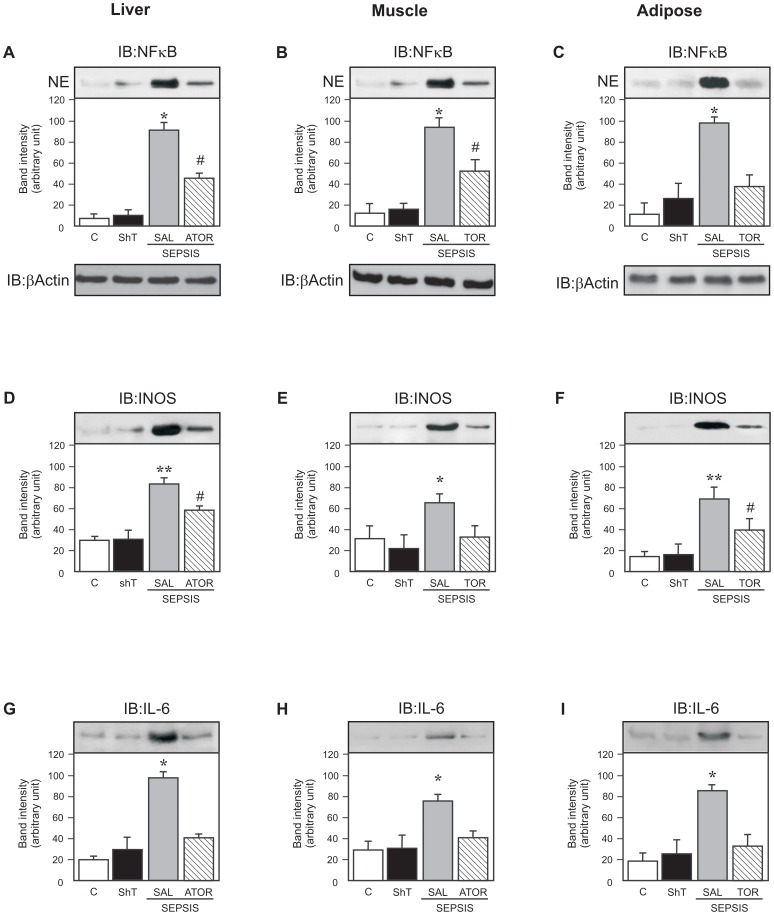
Representative blots show the NFkB activation in nuclear fractions of liver (A), muscle (B) and adipose tissue (C) of sham and septic rats.In this case blots were stripped and reprobed with actin (A–C, lower panels) to confirm equal loading of proteins. Tissue levels of iNOS (D–F) and IL-6 (G–I) expression in liver, muscle and adipose tissue of sham and septic rats. Data are presented as means ± S.E.M from 6–8 rats per group. *P<0.05 (Sepsis/Sal vs. all others groups); **P<0.001 (Sepsis/Sal vs. control); #P<0.05 (Sepsis/Sal vs. Sepsis/Ator). IB, immunoblot; CLT: Sham/Saline; ShT: Sham/Atorvastatin; SAL: saline; ATOR: atorvastatin.